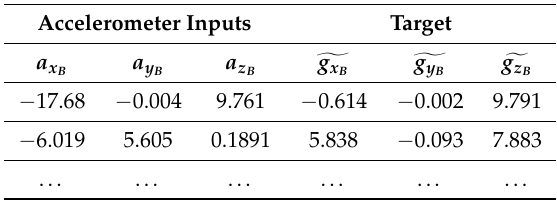
Table 3. Neural network input and target